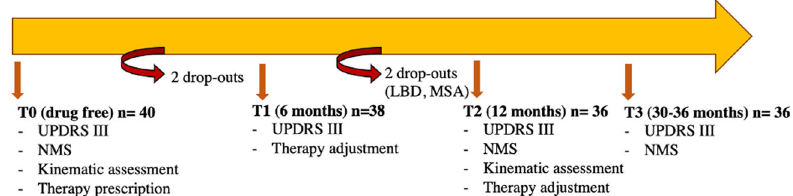
Fig. 3 Work timeline of the clinical and kinematic assessments and interventions. Study design: clinical and kinematic assessments and interventions for each time